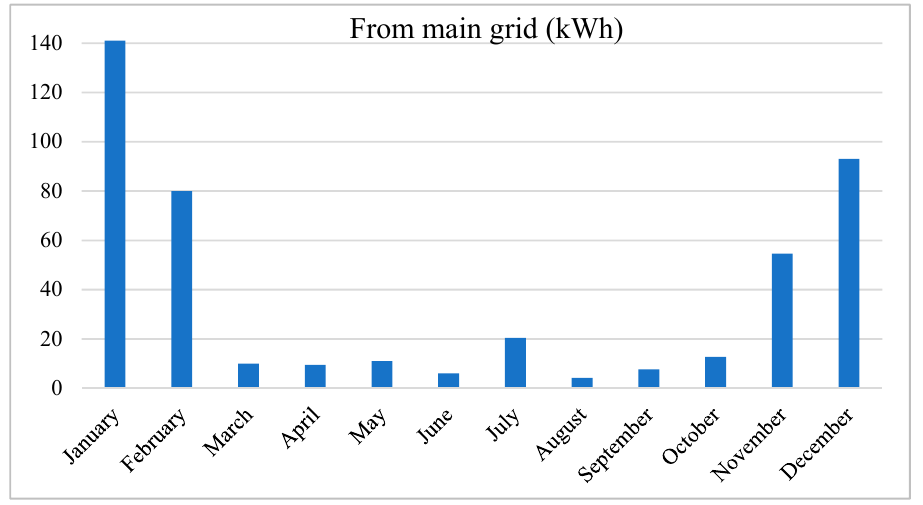
Figure 13. Total load demand per month in 2019 in kWh. 281